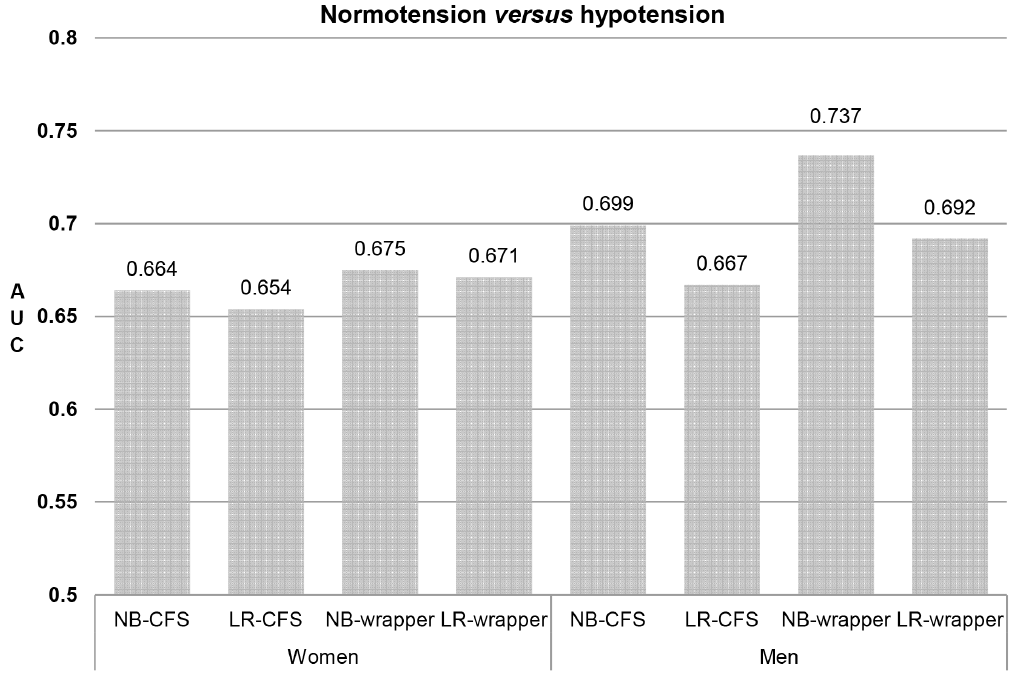
Figure 2. AUC values for normotension versus hypotension using combined indices in women and men. The AUC values were calculated using 10-fold cross validation. AUC: area under the receiver operating characteristic curve; LR: logistic regression; NB: naı¨ve Bayes; CFS: correlation-based feature selection; wrapper: wrapper-based variable selection.